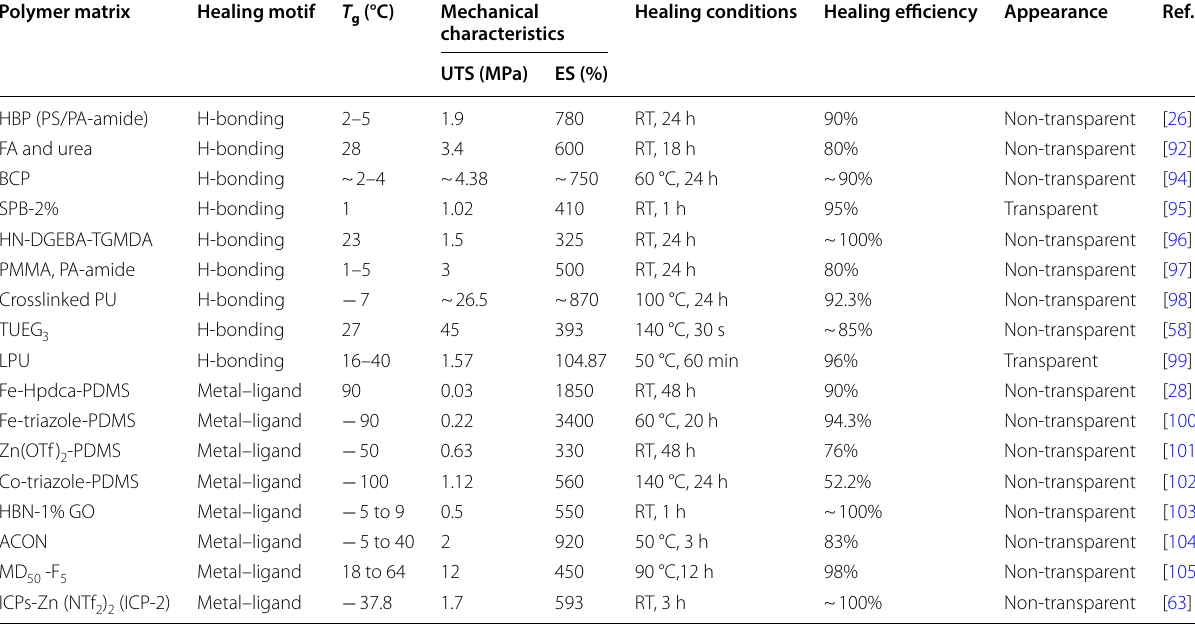
Table 1 Summary of recent self‑healing systems based on supramolecular hydrogen bonds and metal‑coordination crosslinking: mechanical characteristics, self‑healing‑conditions, and